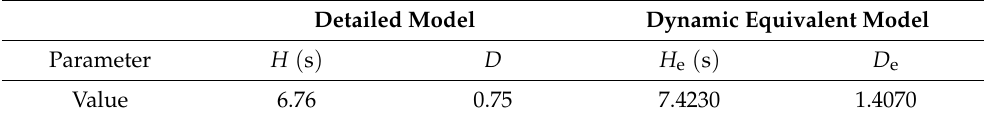
Table 3. Parameters of the detailed model and identification results of the dynamic equivalent model. Detailed Model